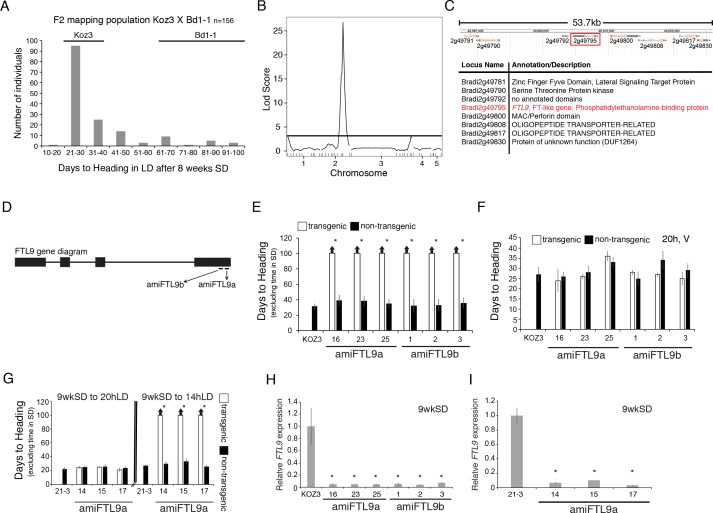
Identification of the FT-like paralog FTL9 as essential for SD vernalization.(A) Koz3 X Bd1-1 F2 mapping population. The F2 population was grown in 8 hr SD for 8 weeks before shifting into 20 hr LD. Days to heading does not include the time the population was in SD. Koz3 and Bd1-1 controls (grown in LD only) flowered as indicated above bars. (B) To identify regions of the B. distachyon genome contributing to the flowering variation in the F2 mapping population from (A), we performed a QTL analysis. Phenotypic data were correlated to genotypic data using 38 indel markers (see Table S4 for primer information and Data S1 for the phenotypic and genotypic data sets). A single, large-effect peak was detected at the bottom of chromosome 2. (C) Diagram of the 53.7 kb interval containing the QTL using version 3.1 of the B. distachyon genome indicating eight annotated genes within the interval. (D) Gene structure of FTL9 showing the location of two amiRNA (amiFTL9a and amiFTL9b) targets in the 3’ region of the gene. We targeted two different areas within the FTL9 gene to control for off-target microRNA effects. (E) Days to heading of Koz3, three independent T1 amiFTL9 transgenics (black bars), and non-transgenic sibling plants (white bars) grown in 20 h days after exposure to 9 weeks of 8 hr SD. (F) Days to heading of Koz3, amiFTL9 transgenics, and the non-transgenic sibling plants vernalized as imbibed seed for 4 weeks at 5°C before outgrowth in 20 hr. (G) Days to heading of Bd21-3, three independent T1 amiFTL9 transgenics (black bars), and non-transgenic sibling plants (white bars) grown in 20 hr and 14 hr. Bd21-3 does not have a vernalization requirement when grown under 20 hr light but does under 14 hr. For E,F, and G arrows above bars indicate that none of the plants flowered at the end of the experiment. (H–I) qRT-PCR of FTL9 expression in amiFTL9 confirming the knock down of FTL9 expression in 8 hr SD. The newly formed ninth leaves on the parent culm were harvested either when the plants were at the ninth leaf stage or after 9 weeks of growth in 8 hr SD (9wkSD). Note the expression of the closely related paralog of FTL9, FTL10 was not affected by the amiRNA nor was VRN2 expression (data not shown). Asterisks above bars indicate statistically significant differences between amiFTL9 transgenic and either wildtype or non-transgenic sibling plants (*p < 0.05).